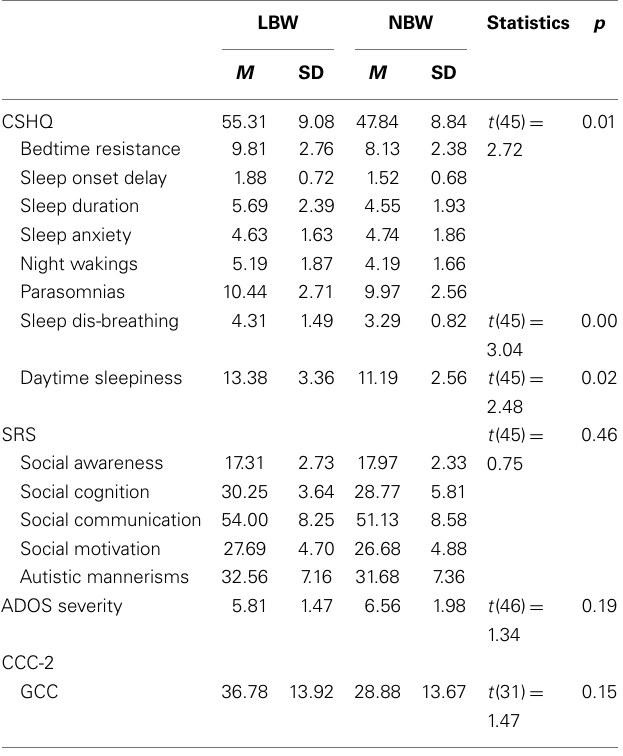
Table 5 | Study 2: descriptive statistics and independent-samples t- tests for CSHQ, SRS, CCC-2, andADOS severity score.